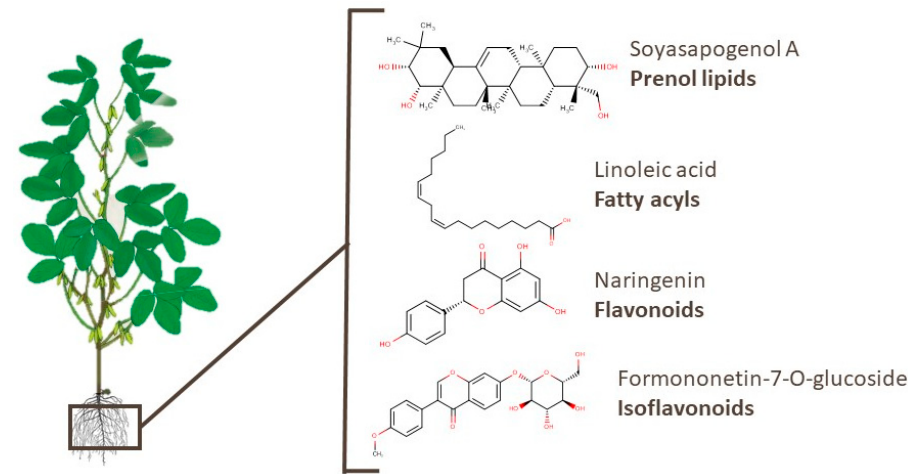
Figure 5. Chemical structures of soyasapogenol A, linoleic acid, naringenin, and formononetin-7-O-glucoside, which are examples of bioactive compounds identified in soy roots.